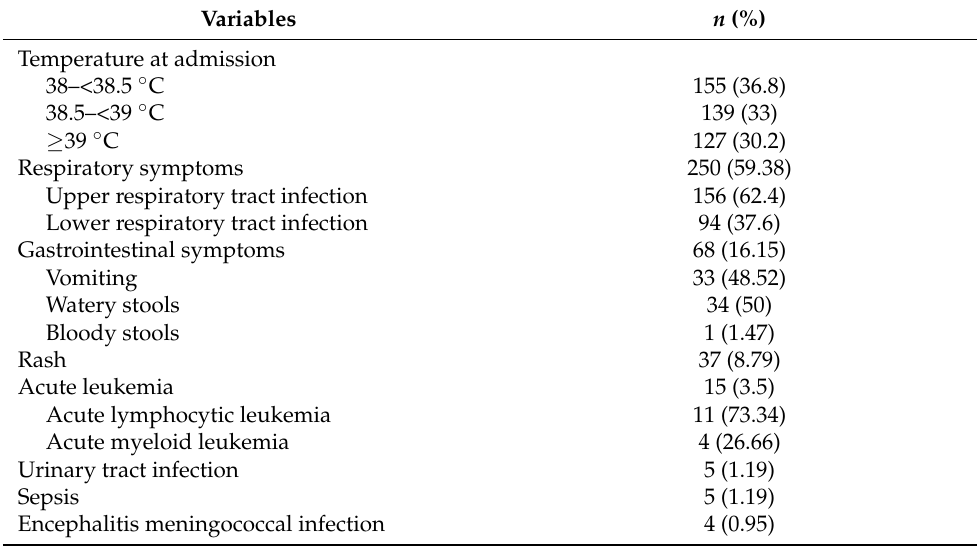
Table 2. Clinical characteristics of studied patients ( n = 421).